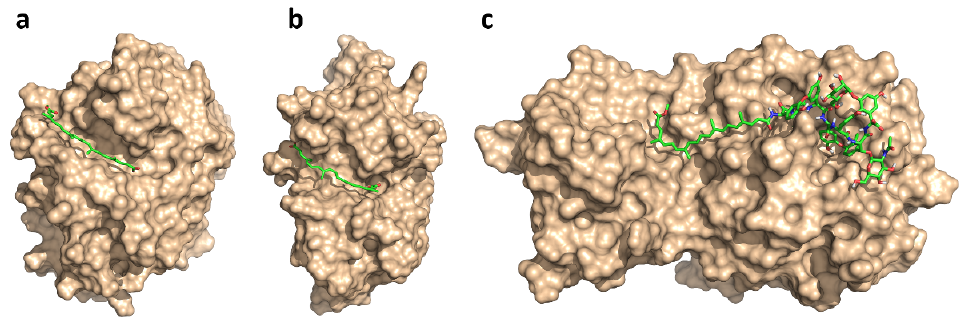
Figure 4. Predicted binding modes of bixin 1a for cathepsins B ( a ) and L ( b ), and teicoplanin pseudoaglycone conjugate 5a for 3CLPro ( c ).